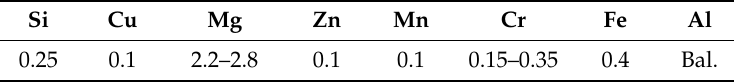
Table 1. Chemical composition of 1060 pure Al (mass fraction /